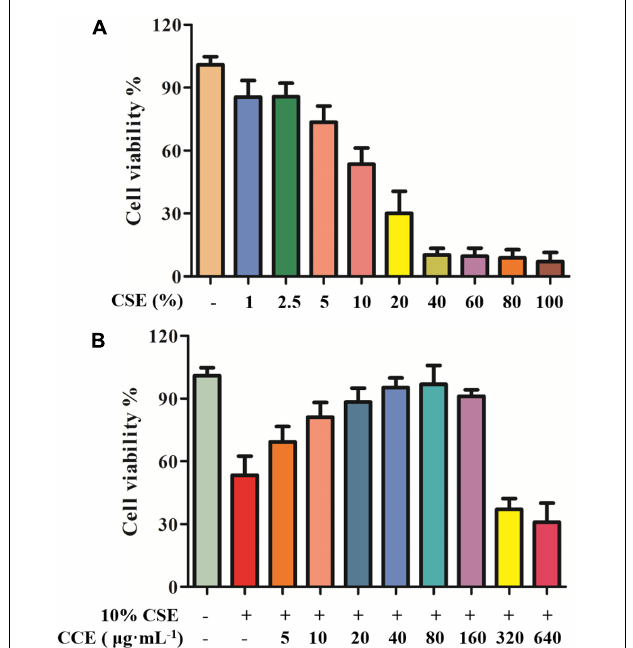
FIGURE 2 | Effects of CCE on cell viability of CSE-induced NHBE cells. CCK-8 assay was conducted to measure the cell viability after being exposed to CSE (A) with or without CCE for 24 h (B) . The optimal concentrations of CSE and CCE were chosen for further experiments. The absorbance values of samples were detected in microplate. Data are expressed as means ± SD ( n = 6).